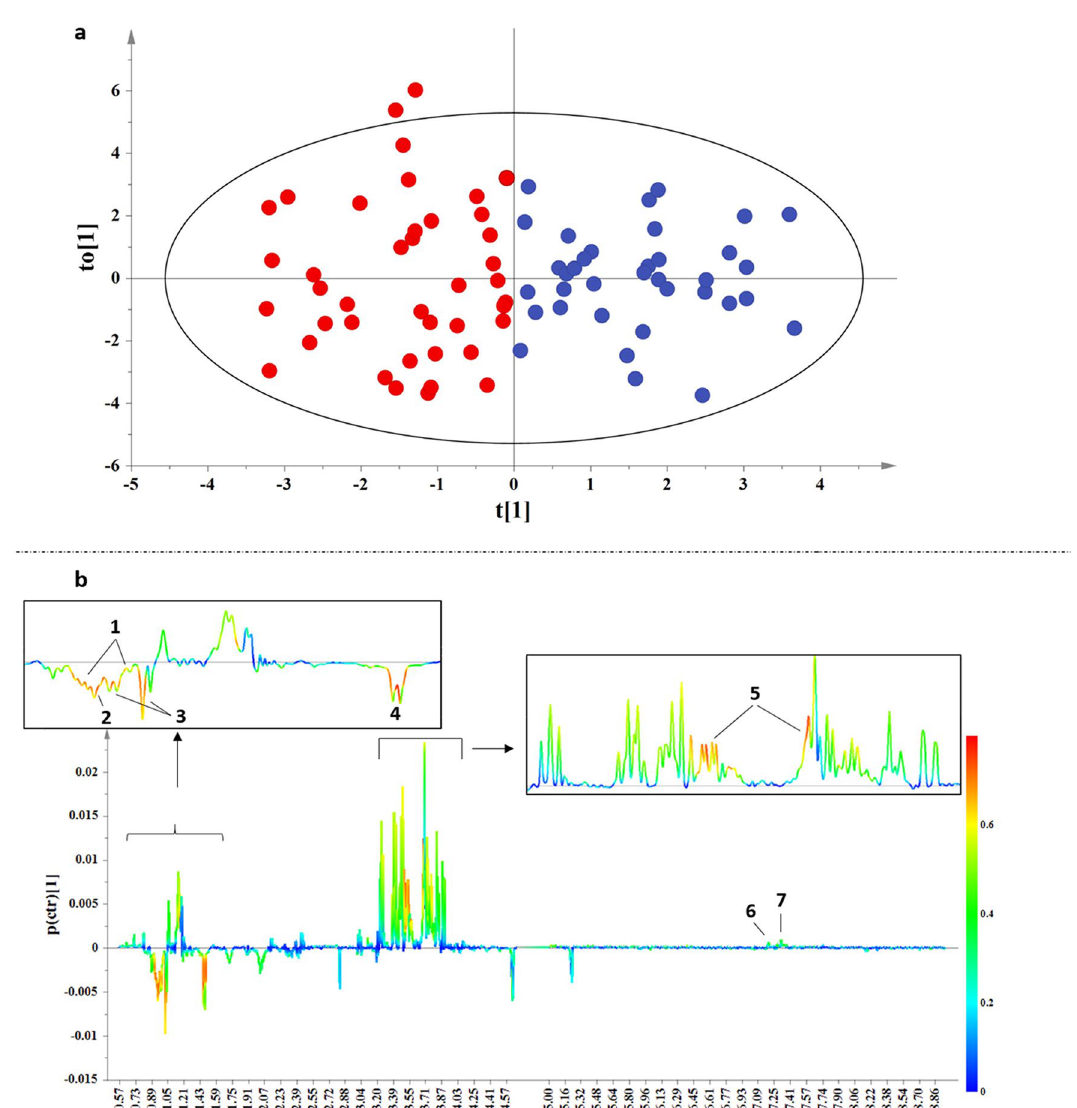
denote IUGR and blue circles AGA samples. ( b ) Loadings plot demonstrate metabolites responsible for discrimination, 1: Isoleucine, 2: Leucine, 3: Valine, 4: Alanine, 5: Glycerol, 6: Tryptophan, 7: